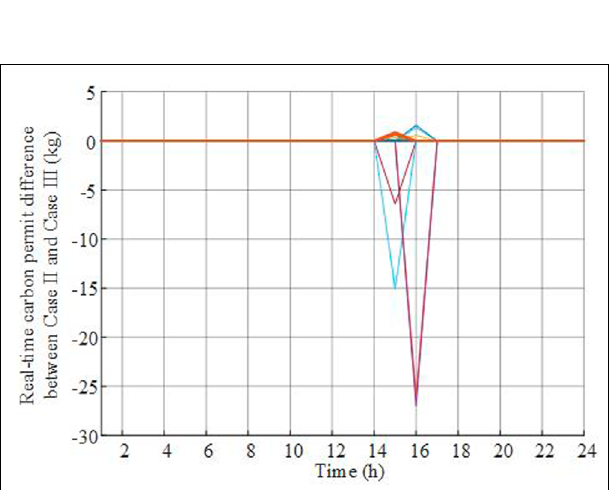
FIGURE 4 | Day-ahead bidding curves under different cases.